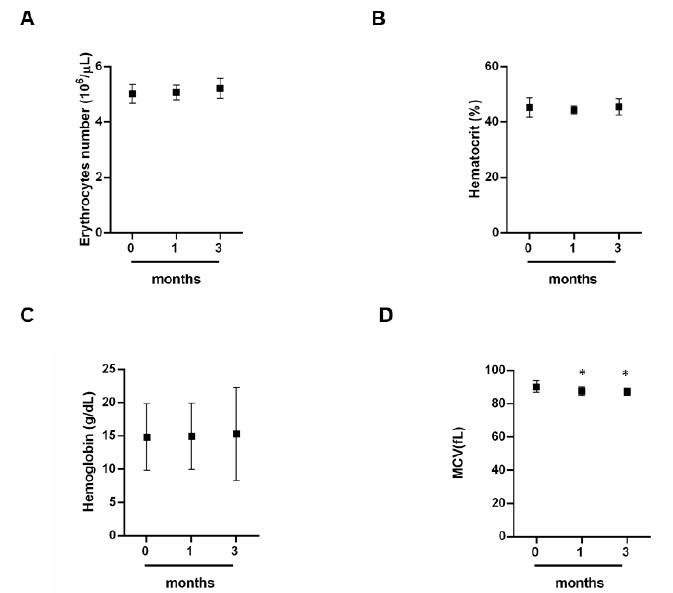
Figure 1. Red blood cells. ( A , B , C , D ) Assessment of percentages of red blood cells at different times 0, 1 and 3 months by a group of 12 professional basketball athletes. Data expressed as the mean ± SD. Significance determined by the t- test student; ( D ) 0 months versus 1 months * ( p = 0.0400) and 0 months versus 3 months * ( p = 0.0152). MCV, average corpuscular volume.